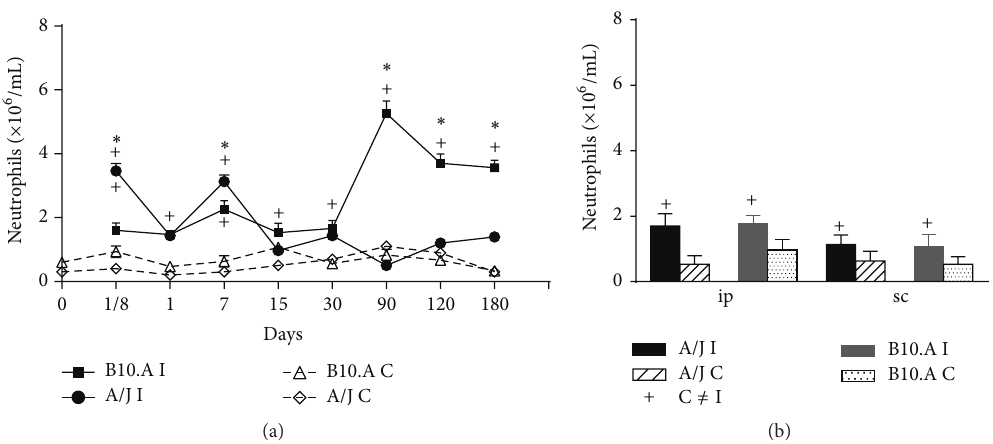
Figure 3: Neutrophilic population in the peripheral blood of resistant A/J or susceptible B.10A mice: (a) kinetics of PMN in mice that had Pb inoculated intraperitoneally; (b) relative population of PMN in mice that suffered intraperitoneal and subcutaneous injection of Pb